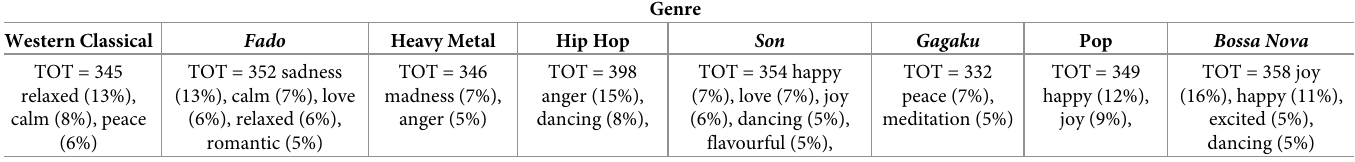
Table 2. Emotions and respective percentages reported above 5% of the total emotion words reported for each genre label in phase 1.